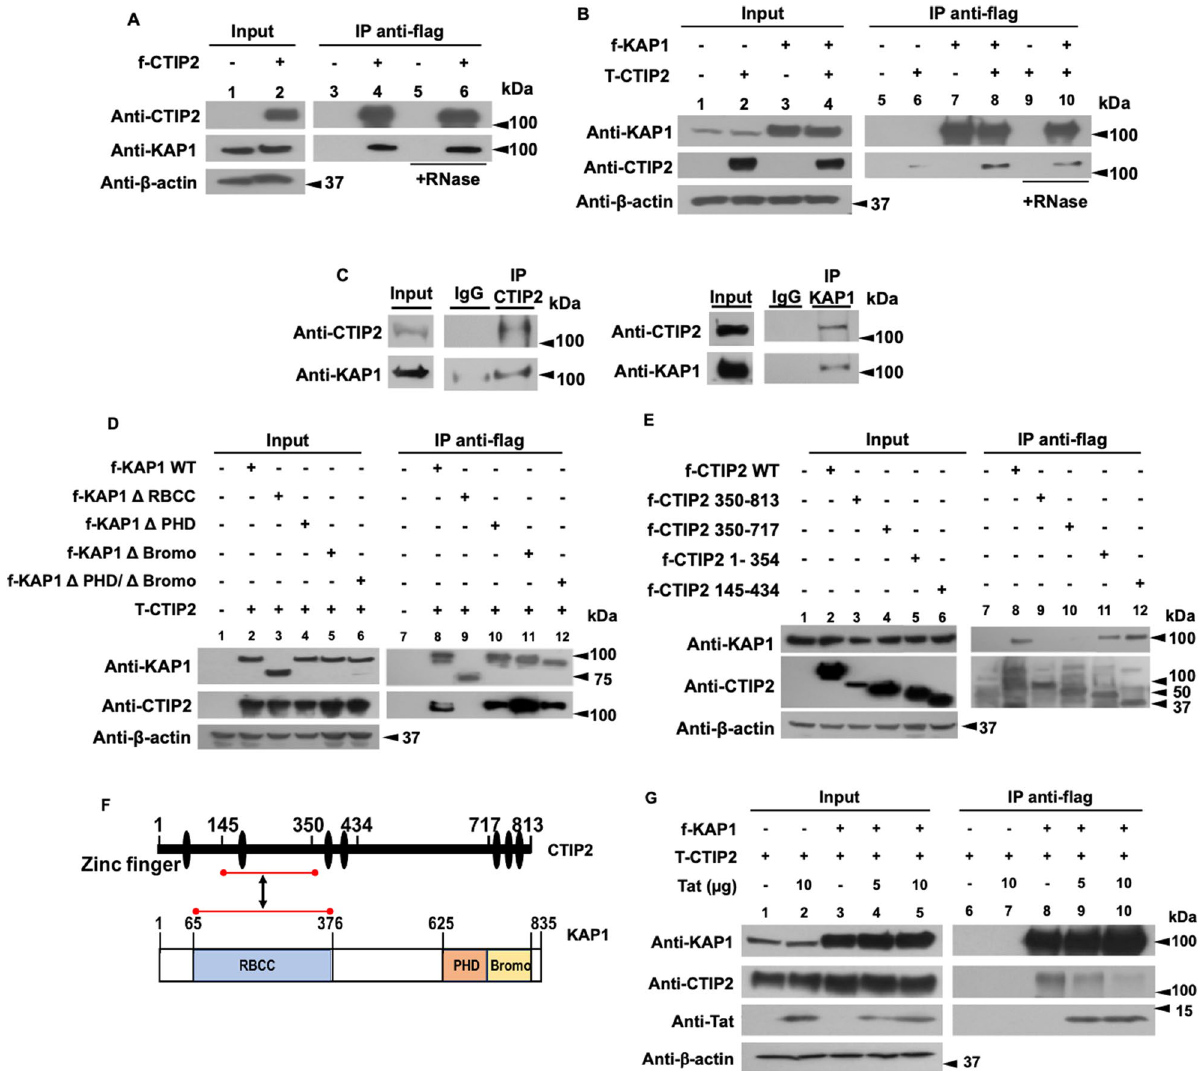
Figure 8. CTIP2 interacts with KAP1 in an RNA independent manner and competes with Tat for KAP1 binding ( A , B ) HEK cells were transfected with flag-CTIP2 ( A ) or flag-KAP1 and Tap-CTIP2 ( B ). 48 h post- transfection, the nuclear protein extracts, treated or not with RNase, were subjected to immunoprecipitation with the flag antibody. The immunoprecipitated complexes were tested by Western blot for the presence of KAP1 ( A ) and CTIP2 ( B ). ( C ) The nuclear protein extracts of microglial cells were analyzed by Western blot for the expression of CTIP2 and KAP1 and submitted to immunoprecipitation experiments with CTIP2 and KAP1 antibodies. ( D ) The HEK cells were transfected with Tap-CTIP2 and one of the vectors encoding f-KAP1 WT: wild type, or KAP1 deleted from the RBCC domain (ΔRBCC), or PHD (ΔPHD), or Bromo (ΔBromo) or both PHD and Bromo domains (ΔPHD/ΔBromo), or with f-CTIP2 deletion mutants, as indicated ( E ). After 48 h, the nuclear protein extracts were immunoprecipitated with flag antibody. The eluted protein complexes were analyzed by Western blot for the presence of CTIP2 and KAP1. ( F ) The interface between CTIP2 and KAP1 structural domains are presented. ( G ) HEK cells were transfected with the indicated vectors in the presence of an increasing dose of Tat. After 48 h, the nuclear protein extracts were treated as in ( D ). The results are representative of at least two independent experiments. Full-length blots are presented in Supplementary Figure